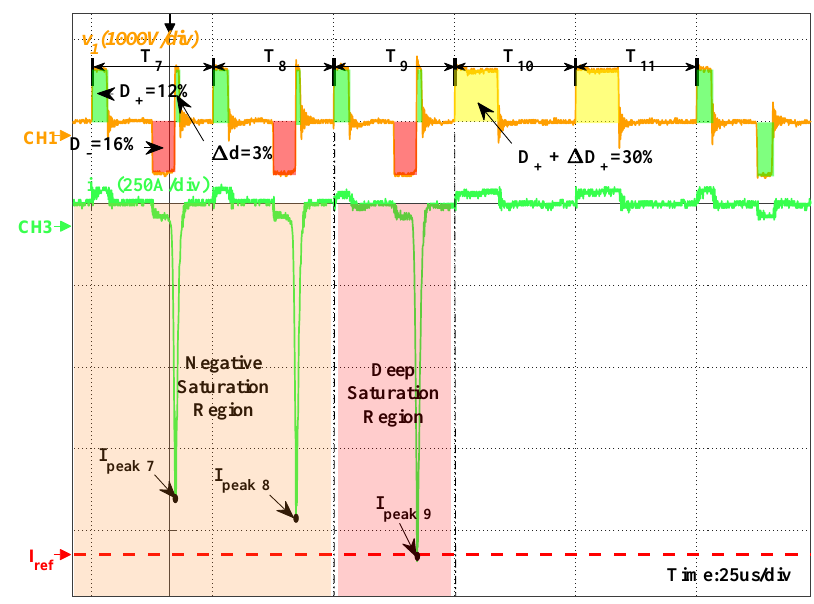
Figure 17. The experimental results of the traditional current feedback control method.